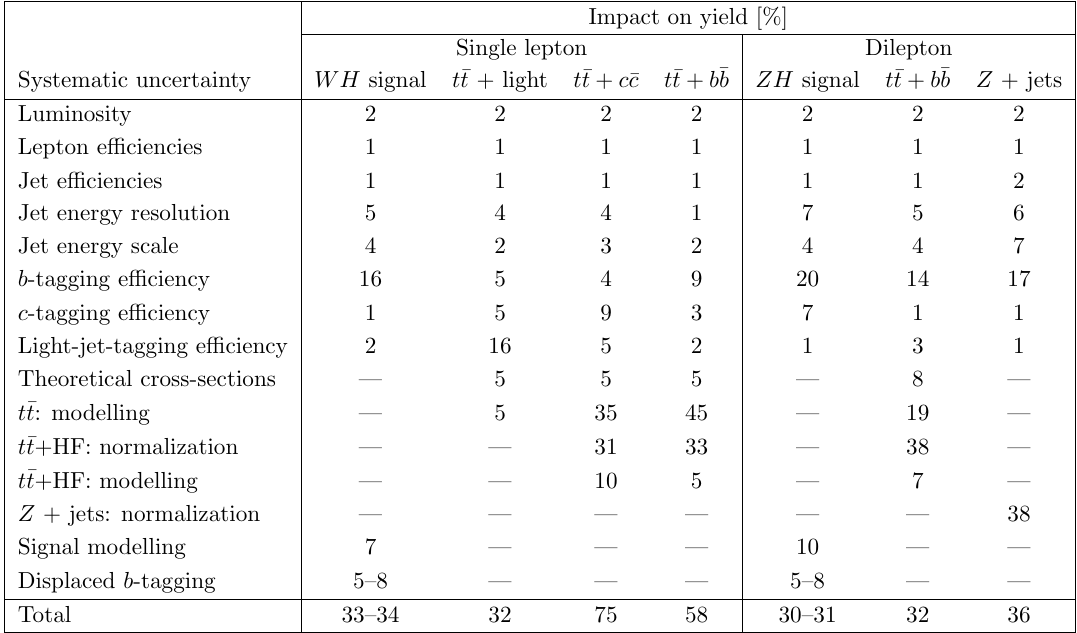
Table 4. Summary of the impact of the considered systematic uncertainties (in %) on the yields for the main backgrounds and the signal ( m a = 60 GeV) for the single-lepton and dilepton regions (1 ‘ , 4j, 4b) and (2 ‘ , 4j, 4b) after the (cid:12)t. The total uncertainty can di(cid:11)er from the sum in (cid:21) (cid:21) quadrature of individual sources due to